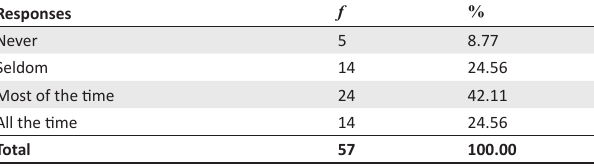
TABLE 3: Respondents’ views on how often they train community members in tuberculosis treatment ( n = 57). Responses